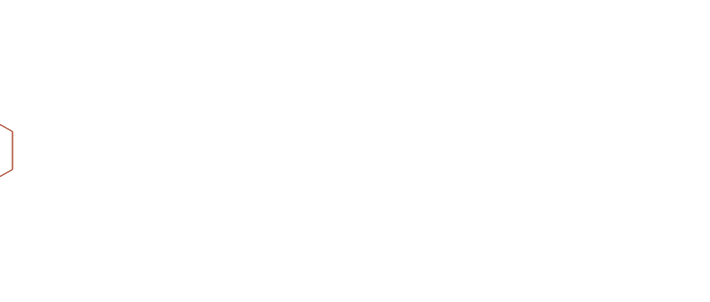
Figure 8. A fragment of Kepler net No. 4612 with marked centers of the regular polygons. Thus, we obtained a large hexagon, the vertices of which pass through 12 regular small hexagons, and the side of which is equal to the quadruple radius of a circle inscribed into a small regular hexagon (Figure 9a). Modeling was performed in the AutoCAD 2022 2D and 3D computer-aided design and drawing software application developed by Autodesk (Figure 9b).